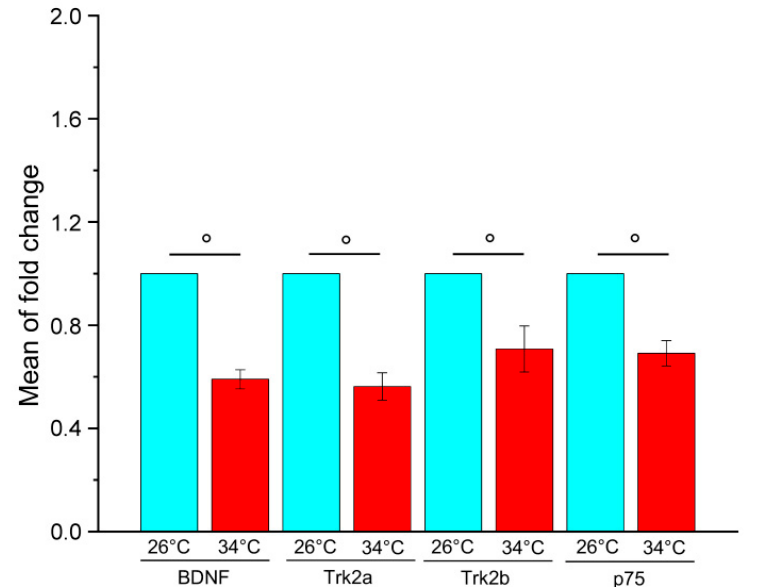
Figure 1. Relative quantification of BDNF, Trk2a, Trk2b and p75 gene expression in the brain of adult WT zebrafish kept at 26 °C and 34 °C for 21 days. For each gene, the expression level at 26 °C was set to 1. The expression levels were normalised against tubulin and expressed as fold change relative to samples at 26 °C. Data are expressed as mean ± SEM and analysed with an unpaired t - test, ° p < 0.01. N = 12. Blue and red colours refer to 26 °C and 34 °C, respectively. Primer sequences used are reported in Table S1.